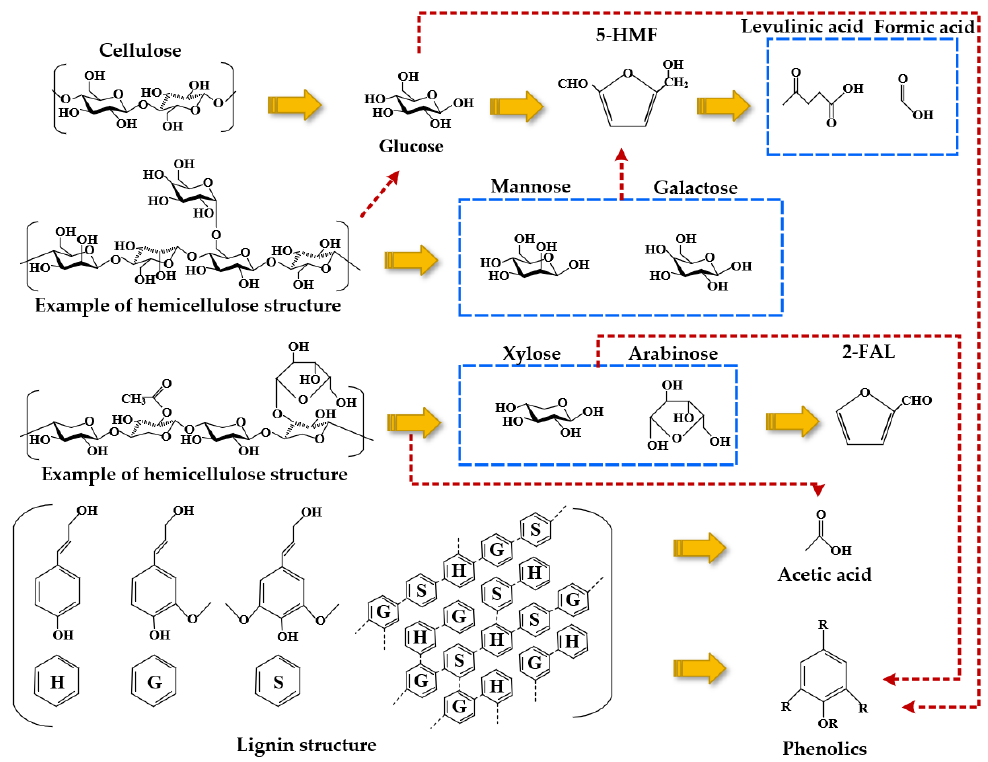
Figure 12. Main composition of insulating paper: cellulose, hemicellulose, and lignin degradation by-products.